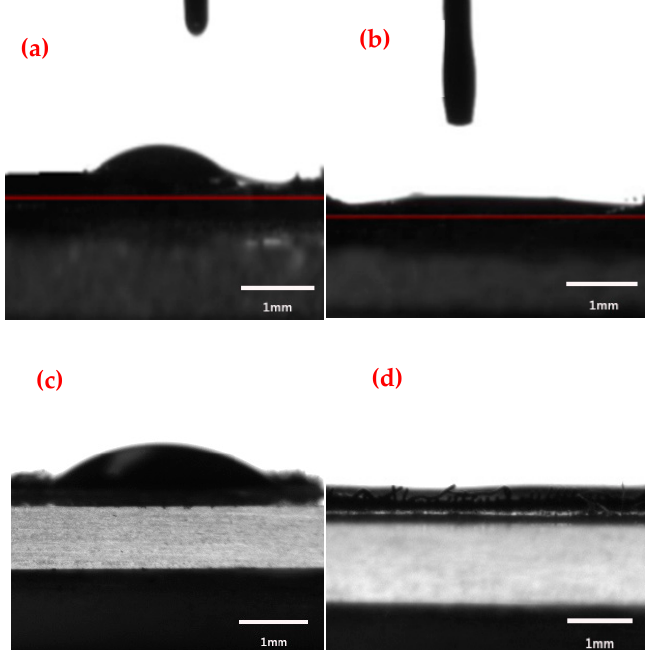
Figure 10. Wettability of oil droplets on the surface of the membrane. ( a , c ) Untreated copper mesh; ( b , d ) As-prepared copper mesh.